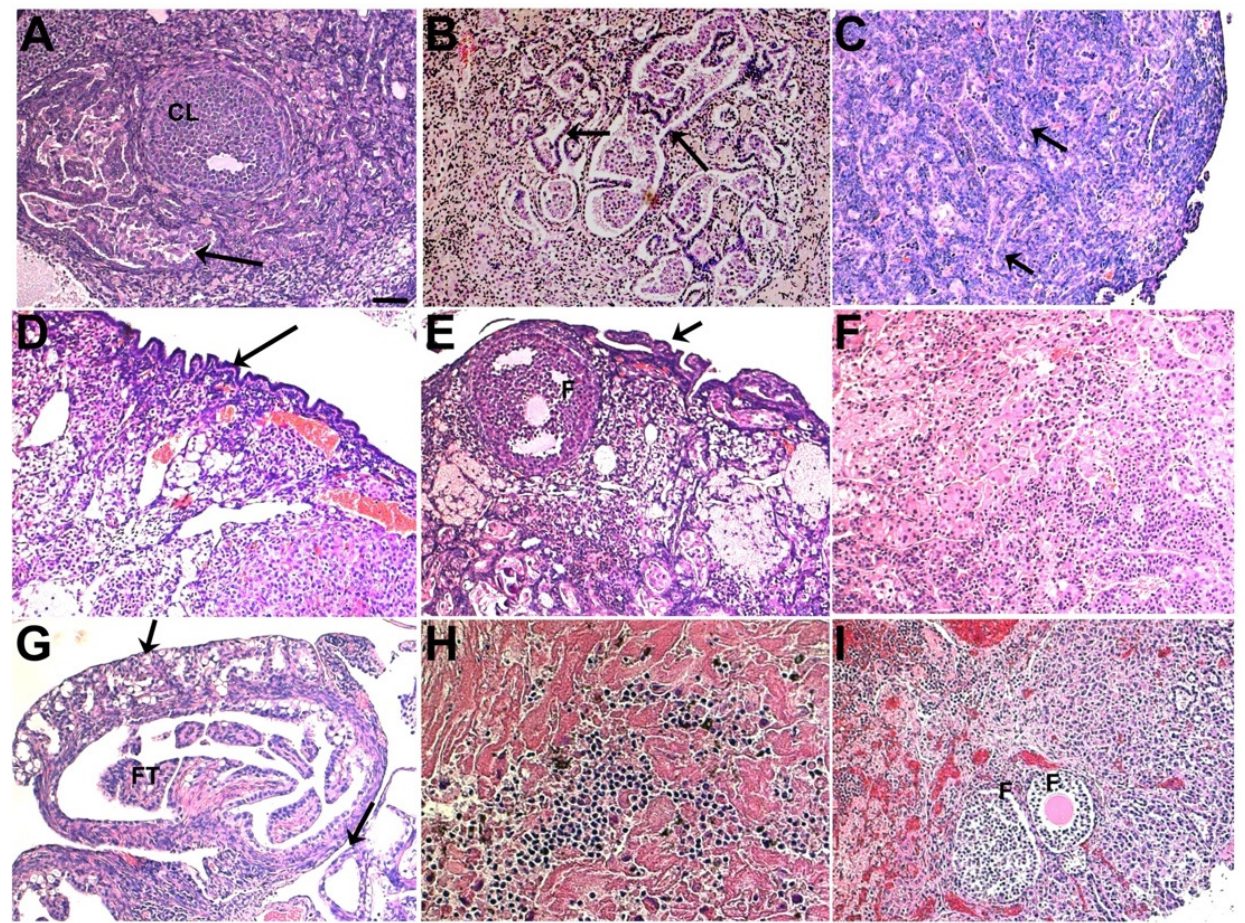
Figure 5. Gynecological malignancies developed in the Pten cohort after Ad-K8-Cre injection. ( A – C ) Representative histological images of endometrioid adenocarcinomas in the ovary from the injected Pten/Kras mice. Arrows indicate villoglandular structures. ( D – F ) Endometrioid hyperplasia (( D ), arrow), endometrioid finger-like lesion (( E ), arrow), and poorly differentiated adenocarcinoma ( F ) in the ovary from the injected Pten/Apc mice. ( G ) Adenomas (i.e., adenomatoid-like lesions) developed on the surface of the FT (( G ), arrows) from the injected Pten/Dicer mice. ( H – I ) Angiosarcoma in the uterus ( H ) and angiosarcoma/hemorrhage in the ovary ( I ) from the injected Pten/Pik3ca mice. F: follicle; CL: Corpus luteum; FT: fallopian tube. Scale bar (same for all panels) = 50 μ m.